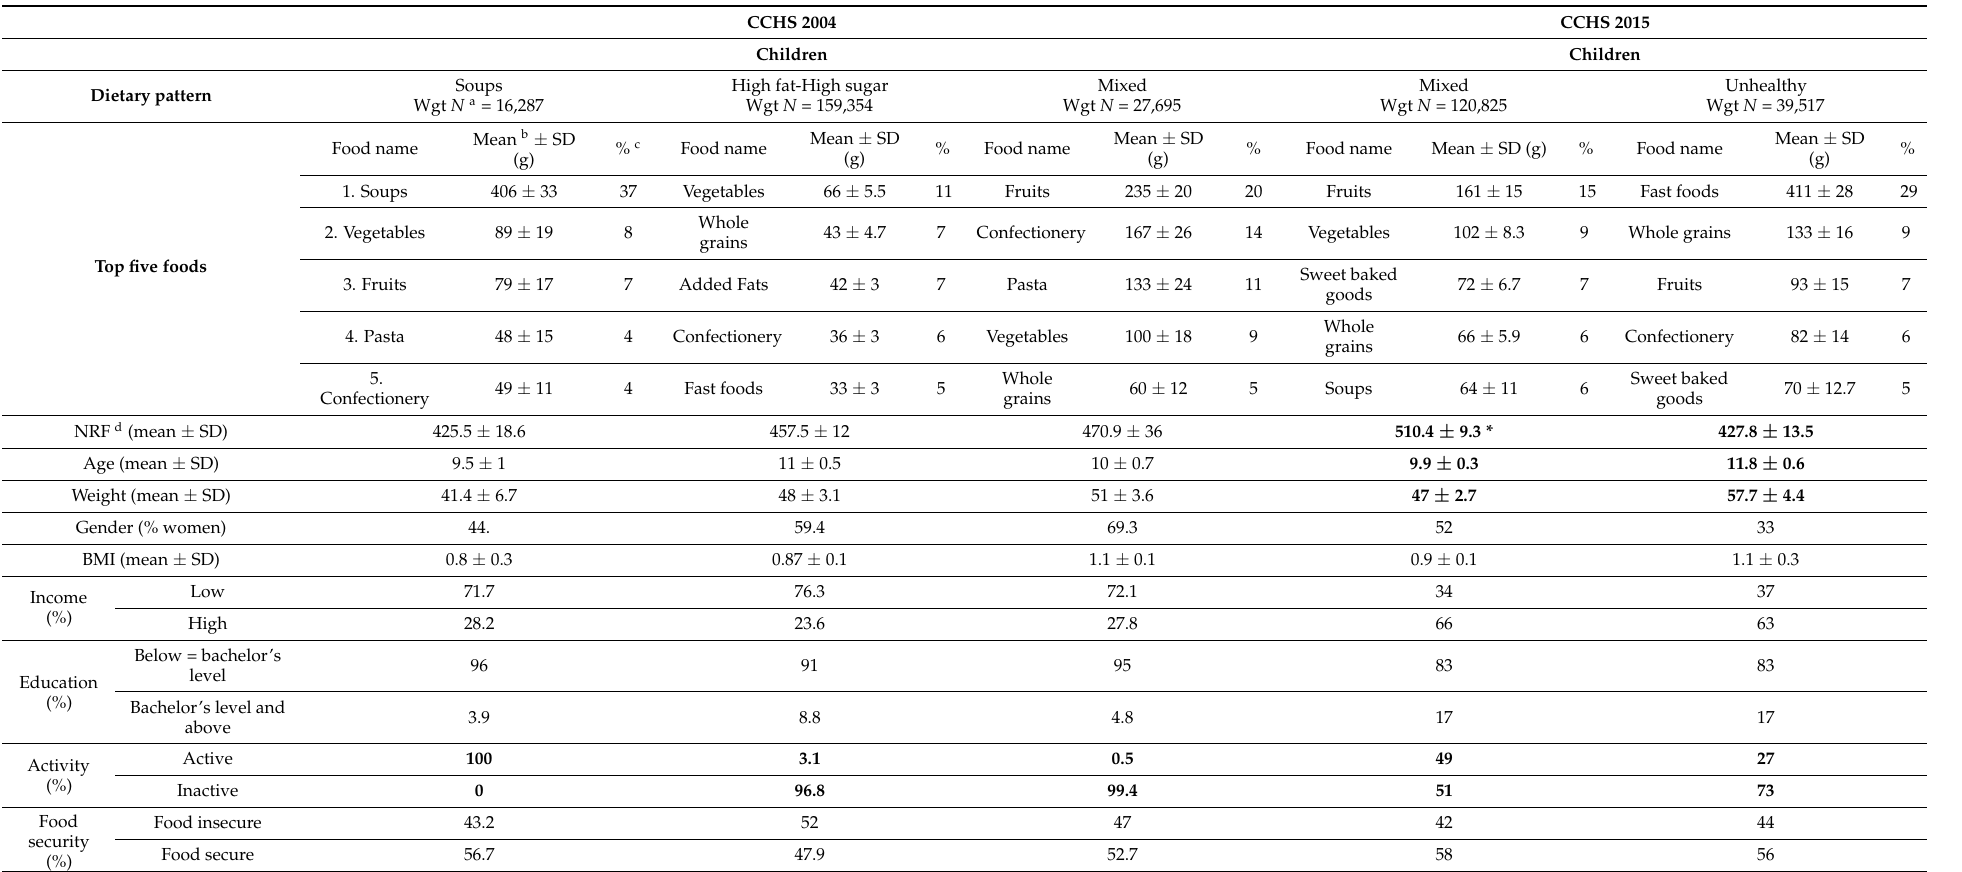
Table 4. Dietary patterns of Indigenous children in 2004 and